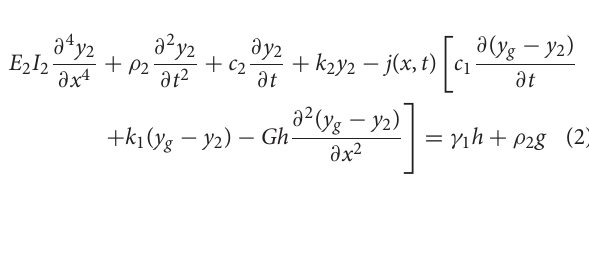
FIGURE 2 | Idealized representation of the problem.